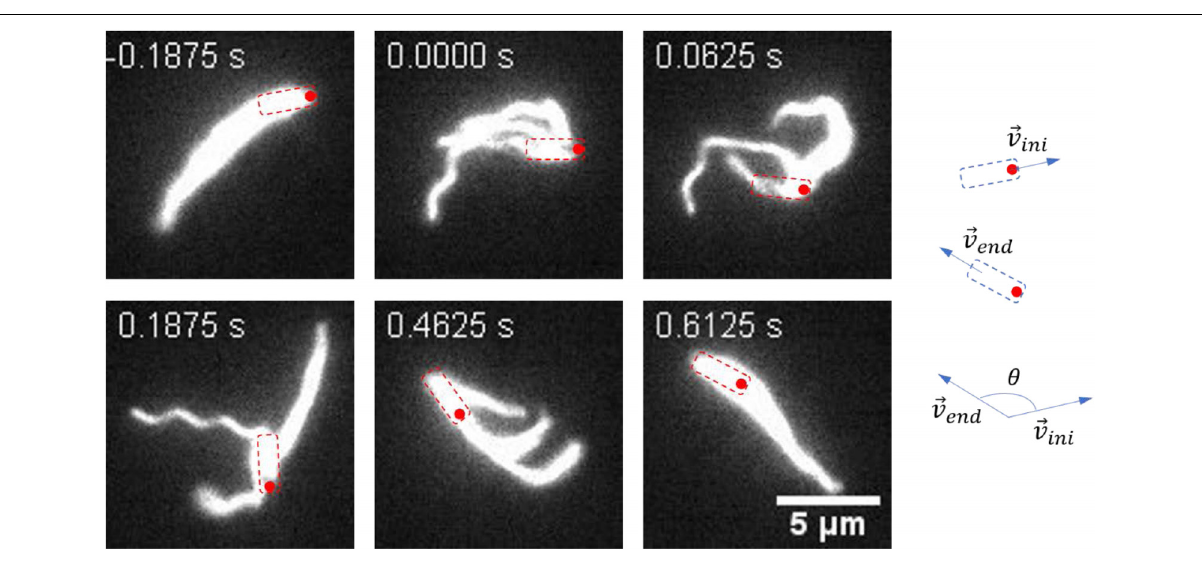
got jammed and the filaments started to unbundle and roll